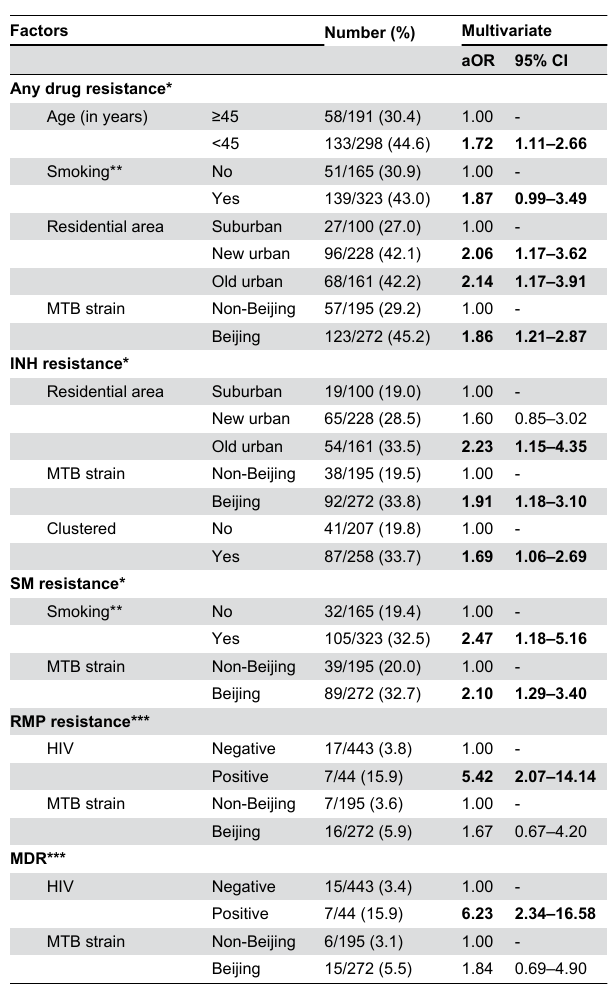
Table 5. Results of multivariate analysis using the logistic regression model on the associations between potential risk factors and drug resistance ( n =